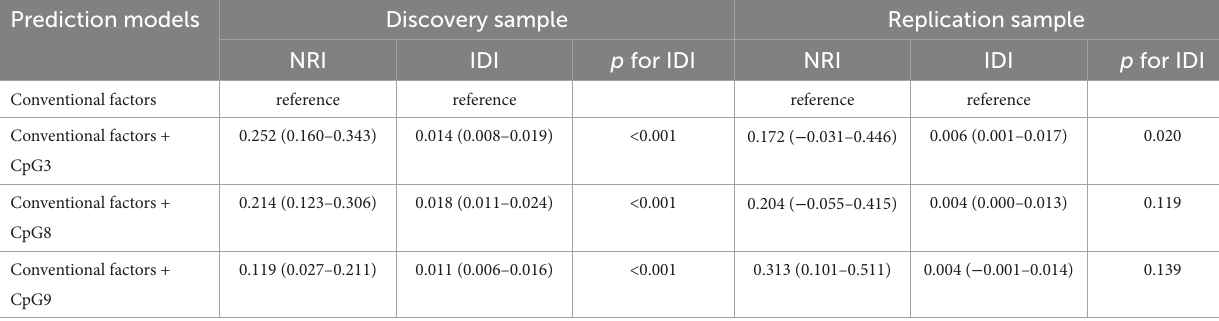
TABLE 4 Discrimination for stroke risk prediction by CORIN promoter methylation over conventional risk